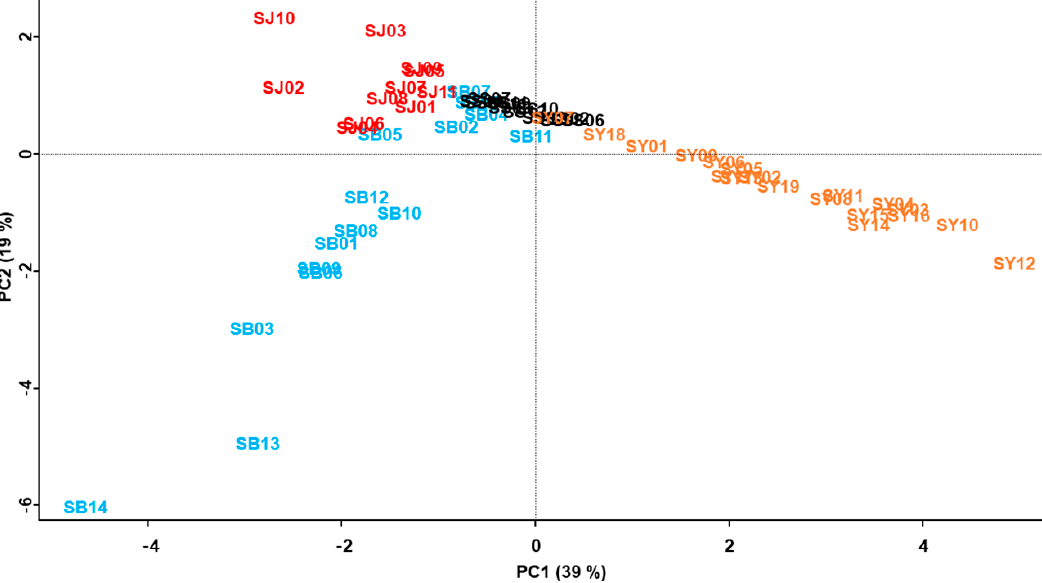
Figure 4. The principal component score plot (PC1 vs. PC2) from the 12 marker compound contents of the Morus samples. PC1 and PC2 contributed to 39% and 19% of the total variance, respectively. SB, root barks; SJ, twigs; SS, fruits; SY, leaves.